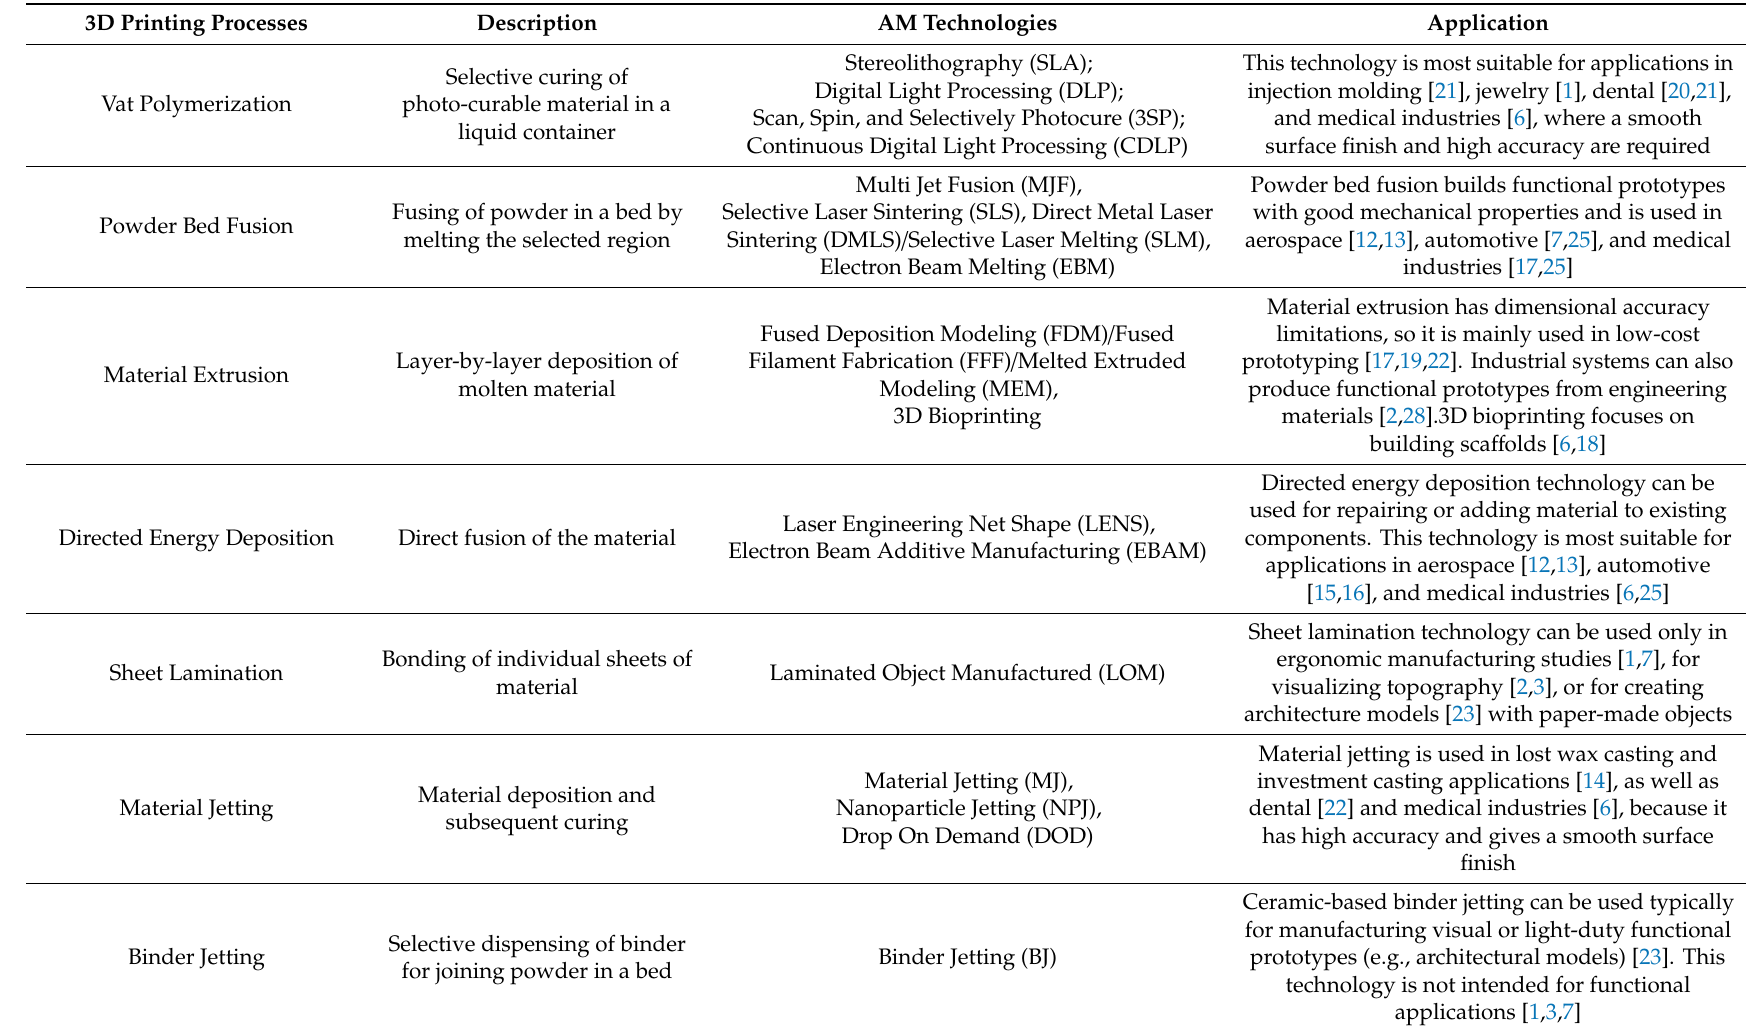
Table 1. Additive manufacturing